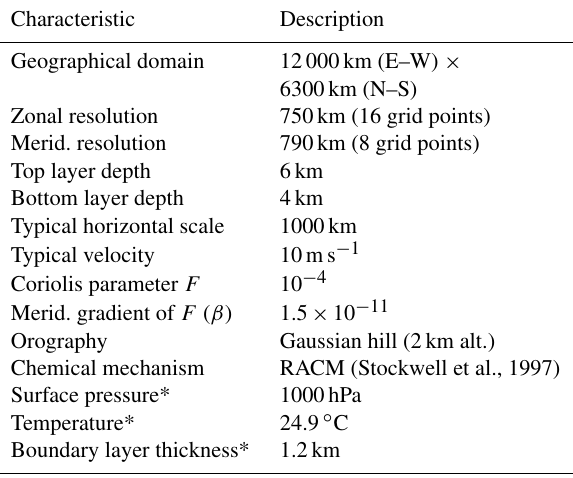
Table 1. QG-Chem model parameters and nondimensional scaling factors. The parameters marked by * are fixed globally and only relevant for the chemical